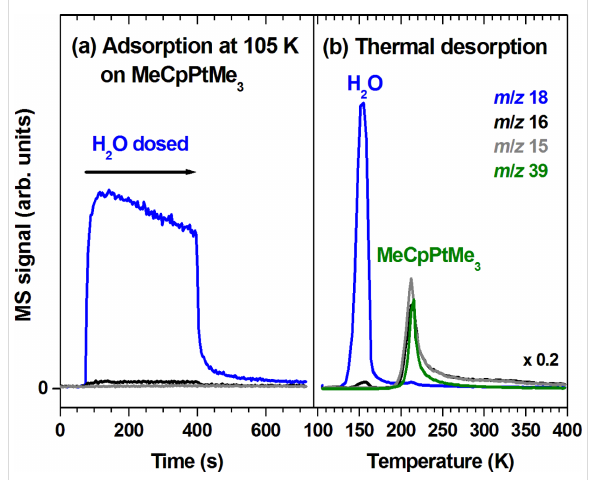
Figure 2: (a) MS signals recorded during leaking of H 2 O onto a film of MeCpPtMe 3 with thickness corresponding to 30 monolayers deposited on a Ta substrate held at 105 K. The amount of H 2 O vapour applied in this experiment was the same as that used for depositing the MeCpPtMe 3 multilayer film. The m / z ratios 18, 16, and 15 were re- corded to monitor leaking of H 2 O as well as possible formation of CH 4 . For CH 4 , the relative intensity of the m / z ratios 16 and 15 amounts to 1:0.9 [10]. (b) TDS experiment performed subsequently on the same sample. Here, m / z 39 (C 3 H 3+ ) is also included as a characteristic MS signal of MeCpPtMe 3 (see [11]).